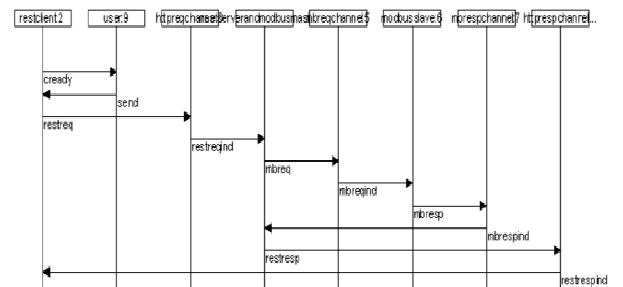
Figure 13 : MSC chart generated using SDL The Message Sequence chart generated for the system for normal flow is shown in figure 13.